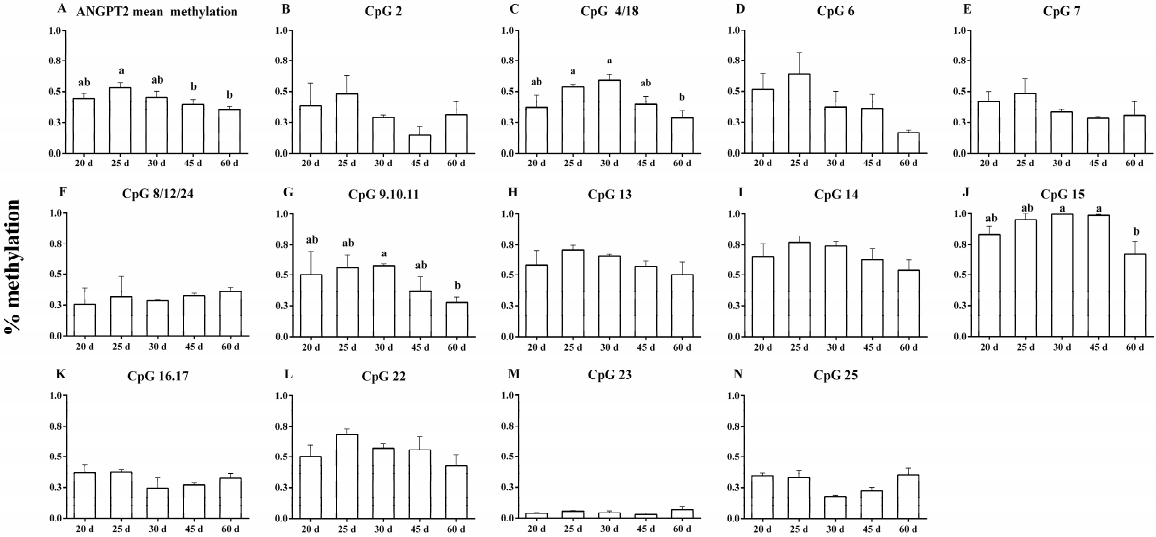
Figure 4. Mean methylation levels and differentially methylated sites in the ANGPT2 target region in the caruncle on days 20, 25, 30, 45, and 60 of pregnancy. ANGPT2 mean methylation levels ( A ); CpG 2 ( B ); CpG 4/18 ( C ); CpG 6 ( D ); CpG 7 ( E ); CpG 8/12/24 ( F ); CpG 9.10.11 ( G ); CpG 13 ( H ); CpG 14 ( I ); CpG 15 ( J ); CpG 16.17 ( K ); CpG 22 ( L ); CpG 23 ( M ); and CpG 25 ( N ). a, b p < 0.02–0.05; values ± S.E.M. with different superscripts differ within each specific gene. CAD was negatively correlated with methylation at the CpG 6 (r 2 = − 0.565; p < 0.04), CpG 7 (r 2 = − 0.545; p < 0.05), and CpG 15 (r 2 = − 0.572; p < 0.04) sites. CSD was